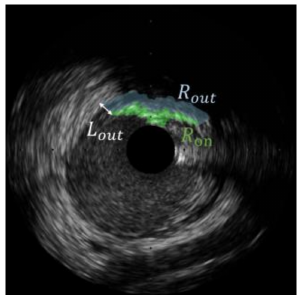
Figure 4. The definition of the region R out outside R on L out is the thickness of R out .